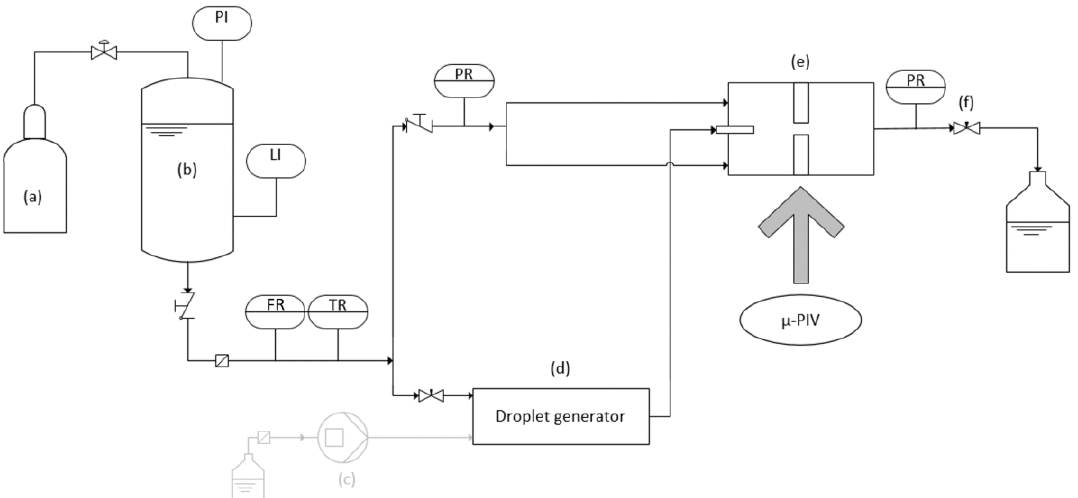
Figure 2. Experimental setup of the 5-fold scaled system ( Ψ = 5) with pressurized gas cylinder ( a ), pressure vessel ( b ), droplet generator ( d ), optically accessible orifice ( e ) and needle valve ( f ). The positive displacement pump ( c ) was not used when performing velocity measurements. The values of the pressure sensors (PR), scale volume flow sensor (FR) and temperature sensor (TR) were recorded during the experiment. The pressure in the vessel (PI) and the level in the vessel (LI) are indicated at the test rig. The µ -PIV system was used to measure the velocity profile in the optically accessible orifice.